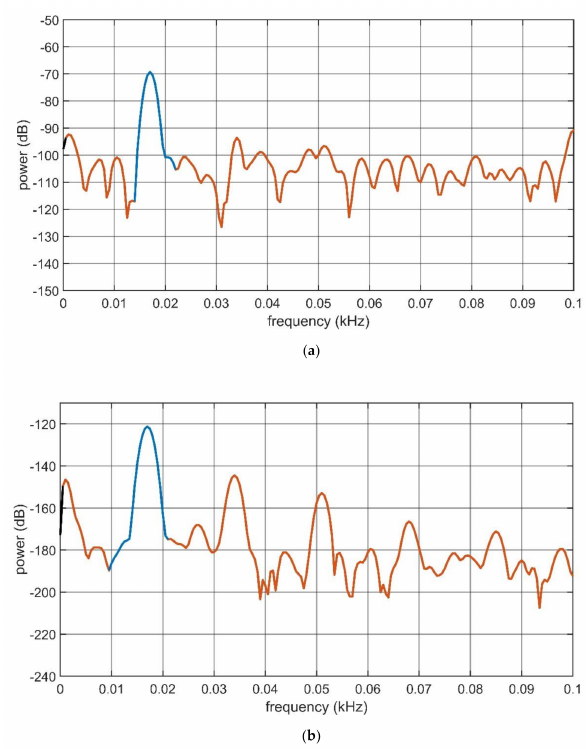
Figure 15. Power spectra of the BC-IL-CP OC voltage ( a ) and SC current ( b ) for the transducer forced at its mechanical resonance frequency (17